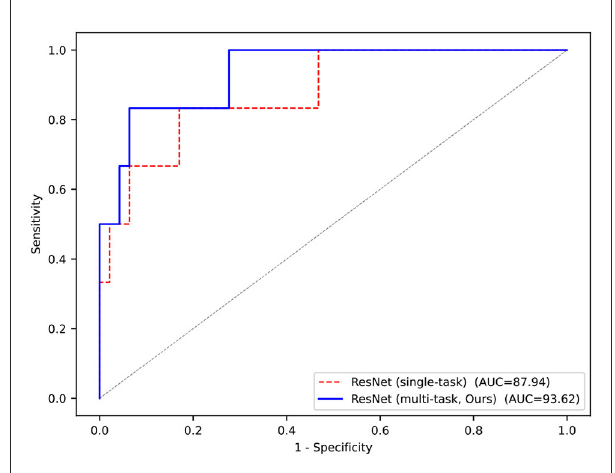
FIGURE4 ROC curves of our multi-task framework and compared method.